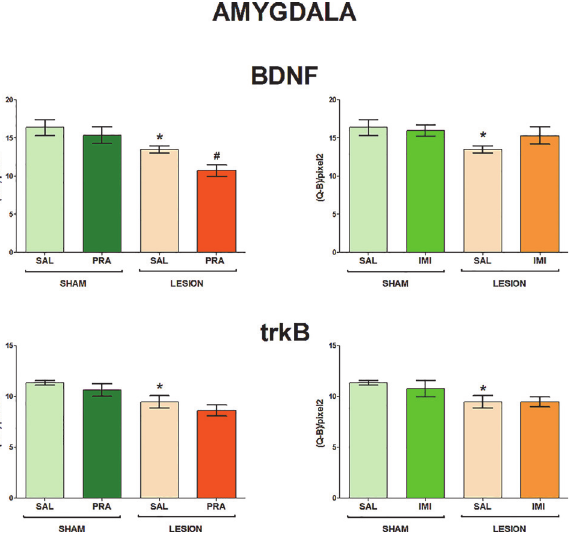
Fig 4. The influence 6-OHDA, pramipexole and imipramine on BDNF and trkB mRNAs in the amygdala. n = 8 – 10. For further explanations see Figs. 1 and 2. doi:10.1371/journal.pone.0117698.g004 PLOS ONE | DOI:10.1371/journal.pone.0117698 March 4,